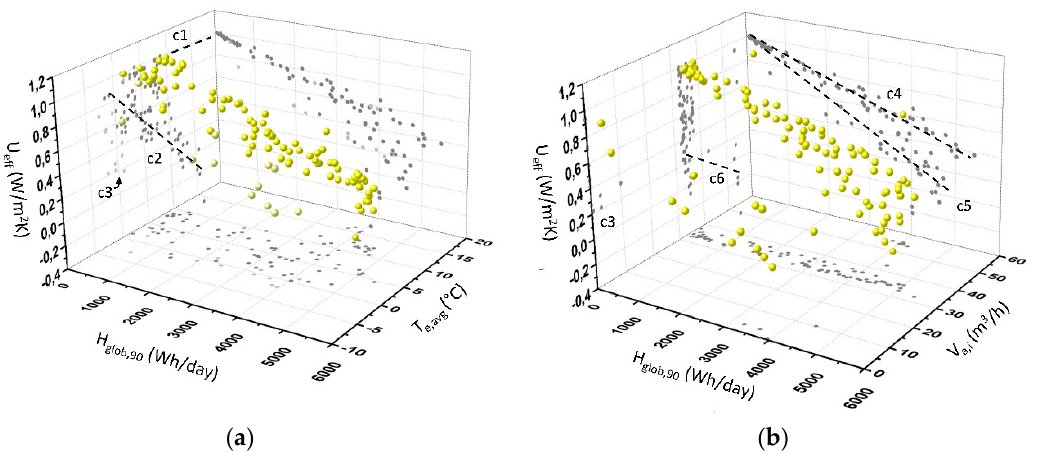
Figure 10 . Dynamic thermal transmittance U eff of the BIPV façade structure with a forced ventilated air gap; ( a ) impact of the daily solar radiation H glob,90 received by the BIPV façade structure and average daily outdoor air T e,avg ; ( b ) impact of the solar radiation and ventilation air flow rate V a,i .